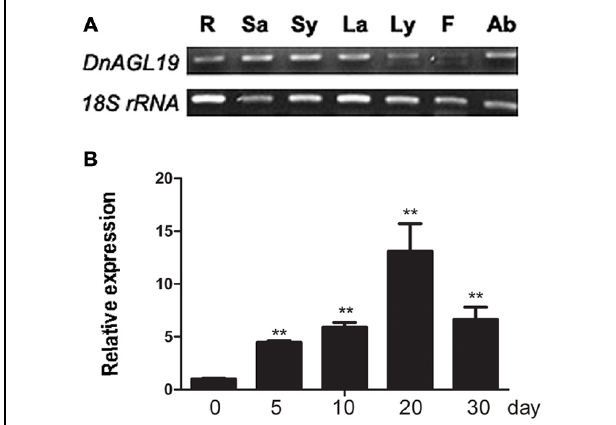
FIGURE 3 | In planta expression of DnAGL19 . (A) Organ-specific expression of DnAGL19 is shown. R, root; Sa: adult pseudobulbs; Sy: juvenile pseudobulbs; La: adult leaves; Ly: juvenile leaves; F: flowers; Ab: axillary buds. Total RNA was extracted from the indicated organs and RT-PCR was performed. 18s rRNA was used as the endogenous control. (B) Time-course dynamics of the expression of DnAGL19 during vernalization. Total RNA was